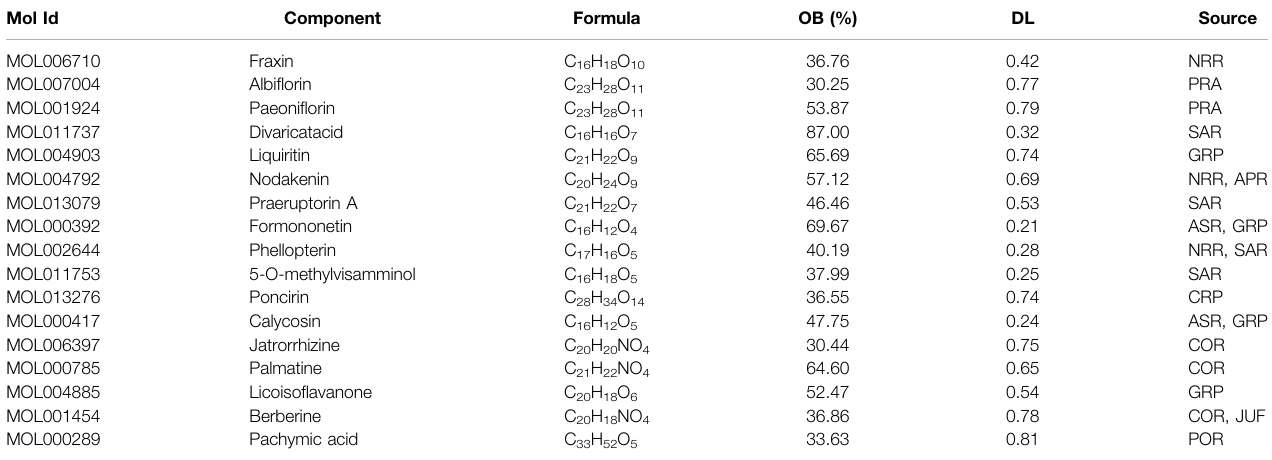
TABLE 2 | Active components of the YSHS